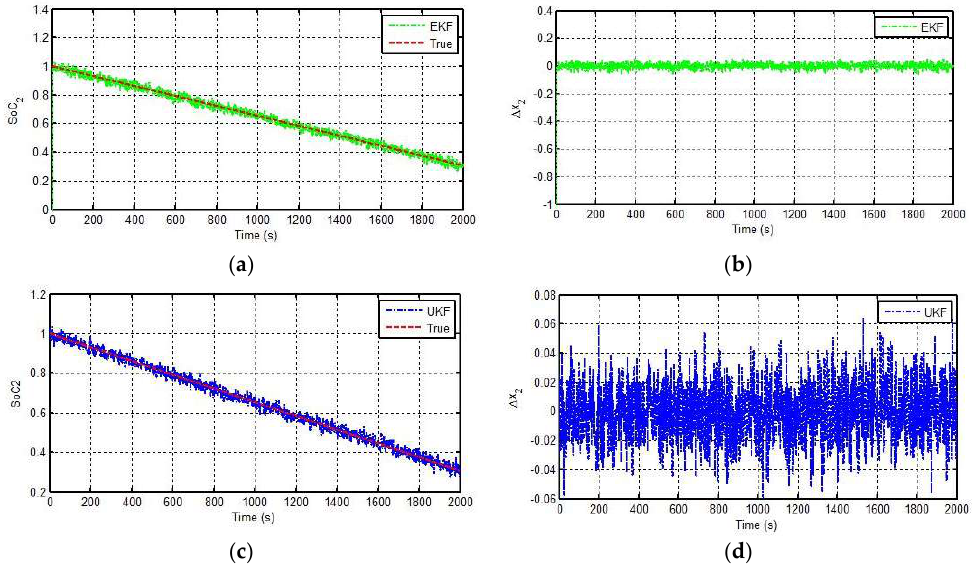
Figure 6. Battery SoC and error in estimation: ( a ) SoC estimation with an extended Kalman (EK) estimator; ( b ) error in EK estimation; ( c ) SoC estimation with an unscented Kalman (UK) estimator; ( d ) error in UK estimation.